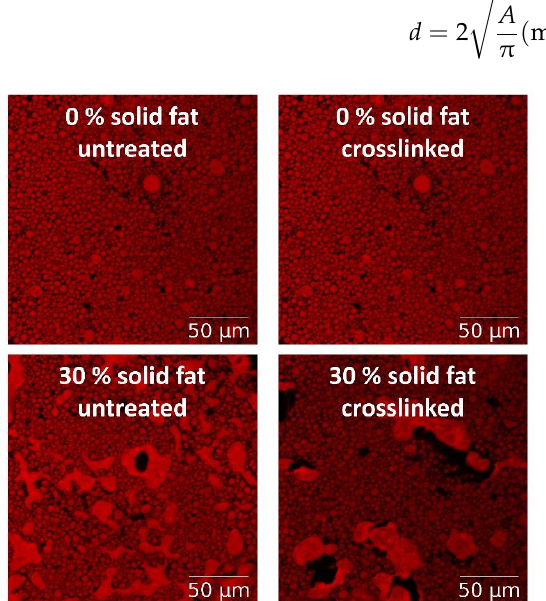
Figure 5. Confocal laser scanning microscope (CLSM) images of uncrosslinked and crosslinked with microbial transglutaminase emulsified fat crystal networks with a total fat content of 70% stained with Nile red.